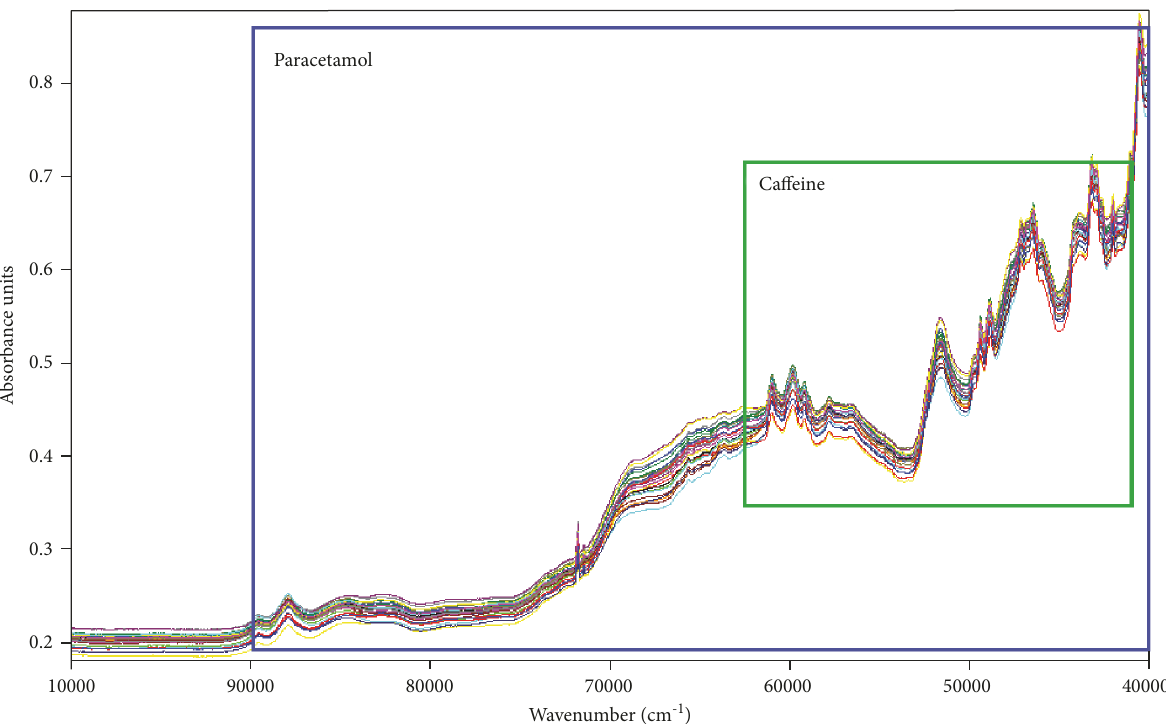
Figure 1: Re fl ectance spectrum of powder mixture recorded at a resolution of 8 cm − 1 for a calibration set. The highlighted blue area de fi nes the spectral ranges selected for the paracetamol, and the green area de fi nes the spectral ranges selected for the ca ff